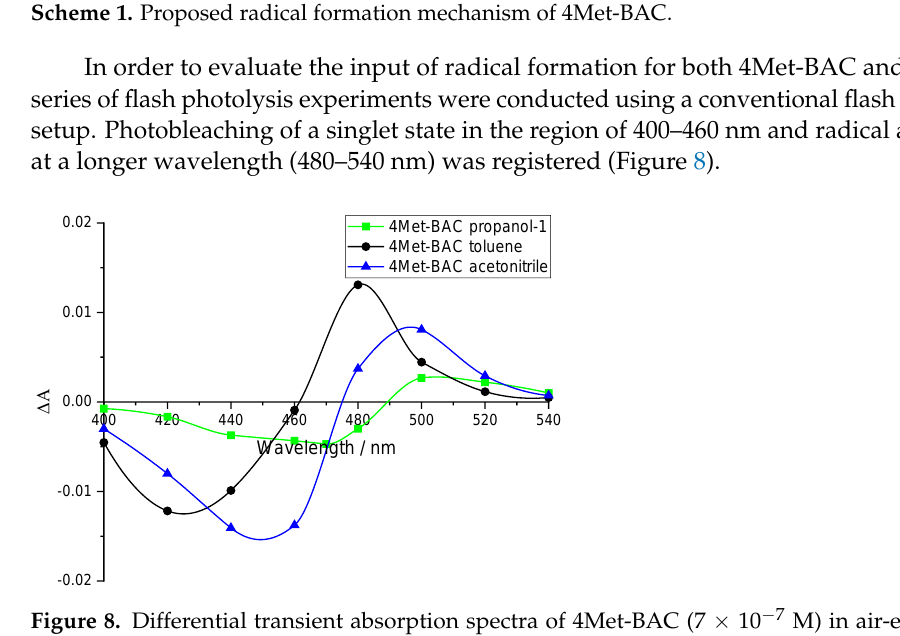
Figure 9. ( a ) Differential transient absorption spectra of 4Met-BAC (7 × 10 −7 M) in propanol-1 100 ms after flash. ( b ) Differential transient absorption spectra of MBAC (1 × 10 −6 M) and 4Met-BAC (1 × 10 −6 M) in air-equilibrated propanol-1 50 ms after flash.